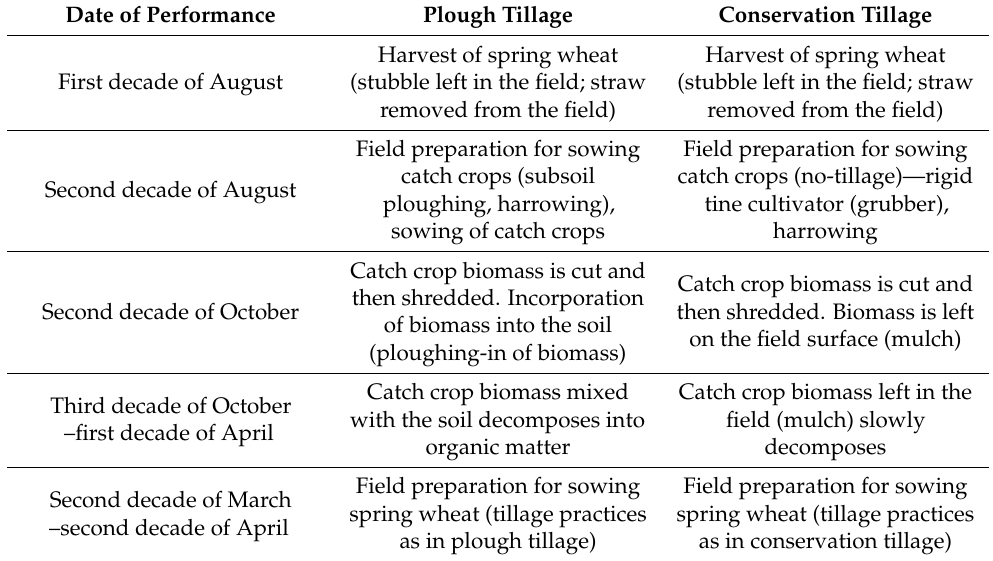
Table 1. The design of agronomic operations related to the cultivation of catch crops and spring wheat.